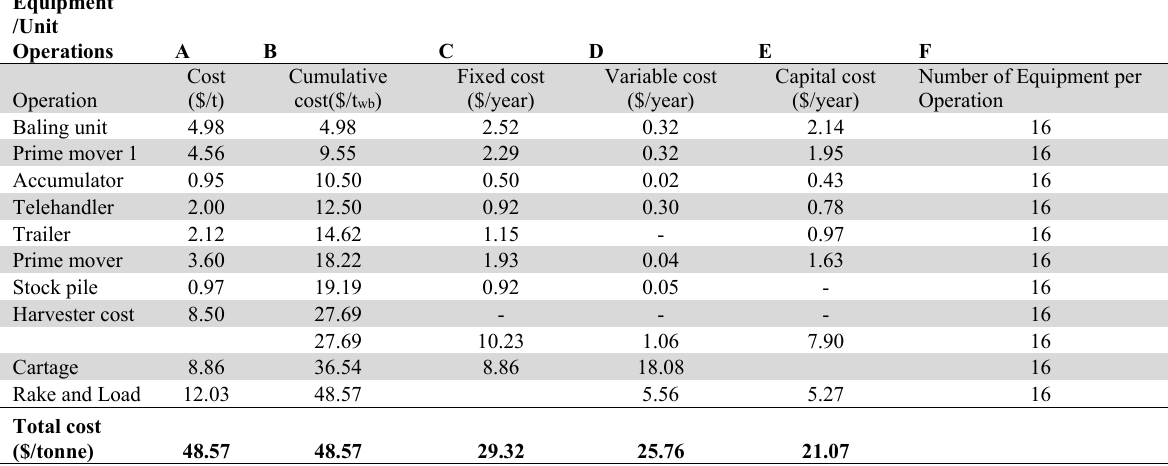
Summary of the cost of recovering, baling, and stacking cane residue